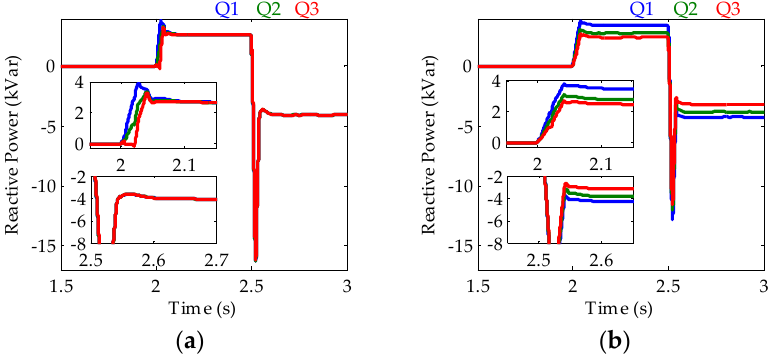
Figure 10. Simulation waveforms of the reactive power of CHBR modules under different working conditions by the use of ( a ) the proposed control strategy and ( b ) the conventional control strategy.